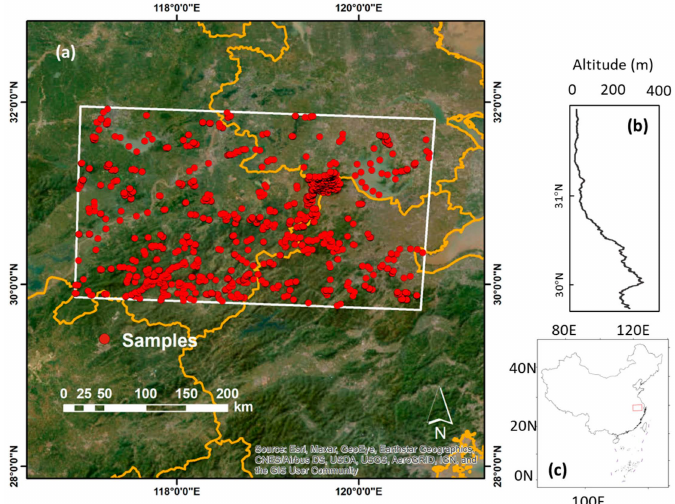
Figure 1. Study area. Boundaries and field-ground truth samples are labelled in the figure ( a ). The altitude profile is displayed in the subpanel. The altitude profile representing the average altitude of pixels with the same latitude is displayed in the panel ( b ). The relative position of the study area is shown in panel ( c ).